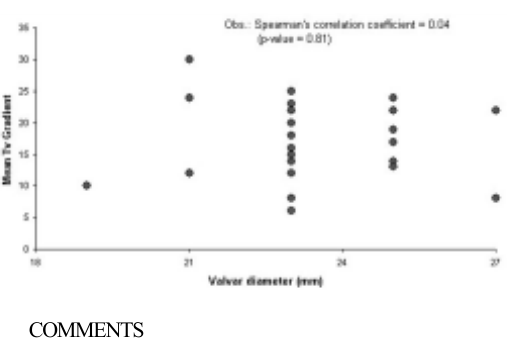
Table 2. Relationship between the mean transvalvar gradient and the diameter of the valvar